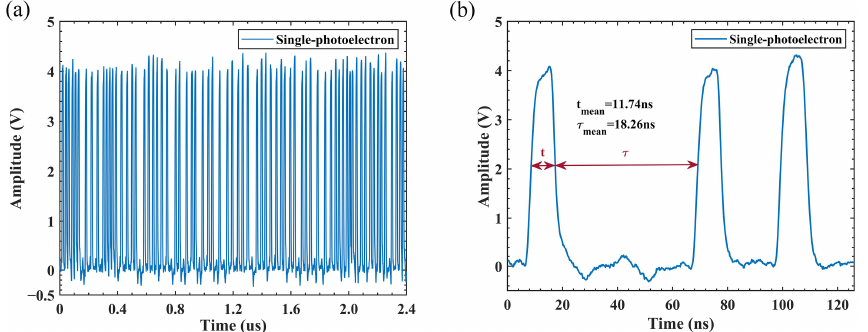
Figure 9. The characteristics of PMT output pulse: ( a ) the single-photoelectron waveform over 2.4 µs, ( b ) the single-photoelectron waveform over 120 ns.